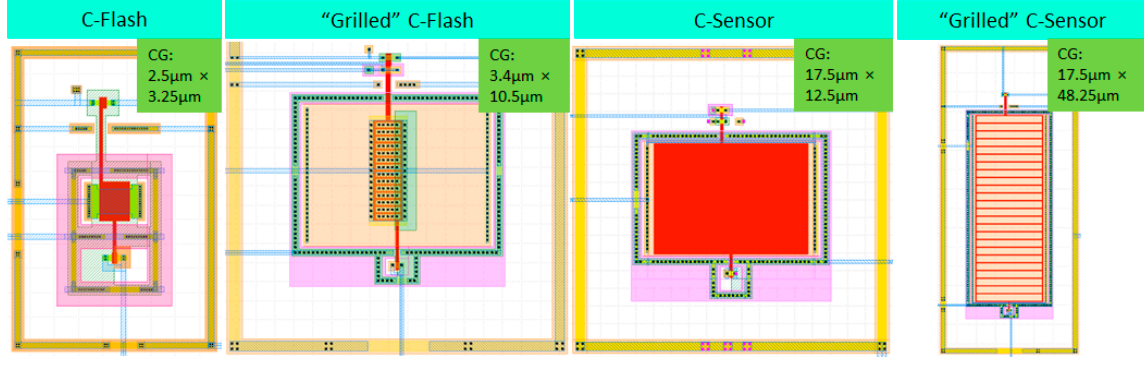
Figure 6. Types of FG-based C-Flash and C-Sensor devices.